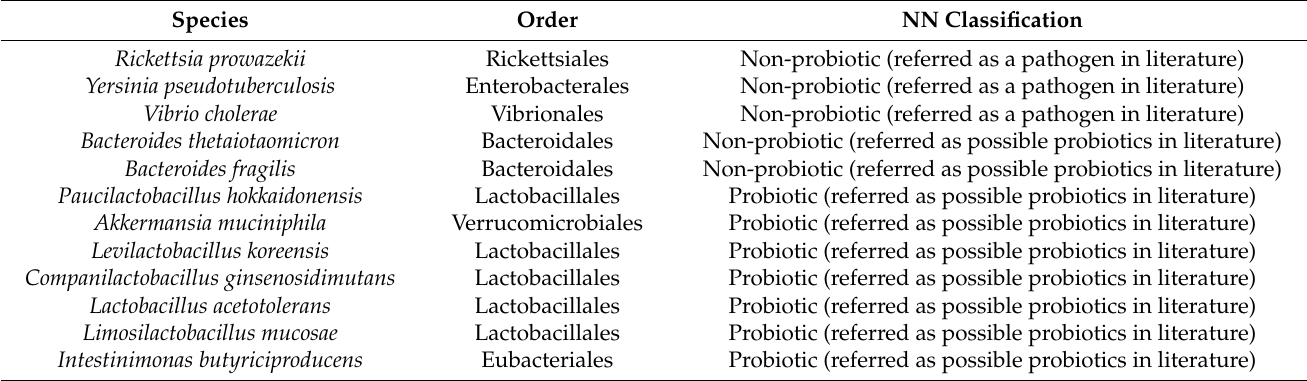
Table 4. Microorganisms included in the test